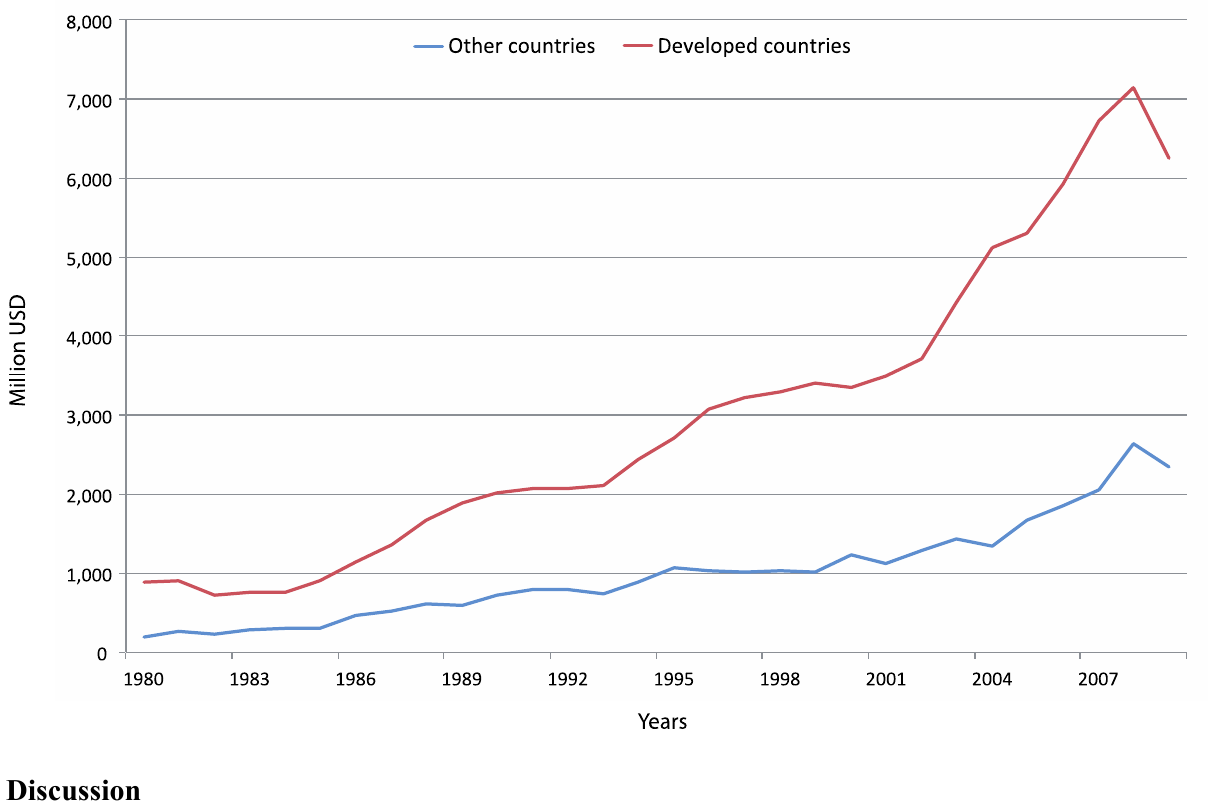
Figure 7. Exports (in millions USD) (source: